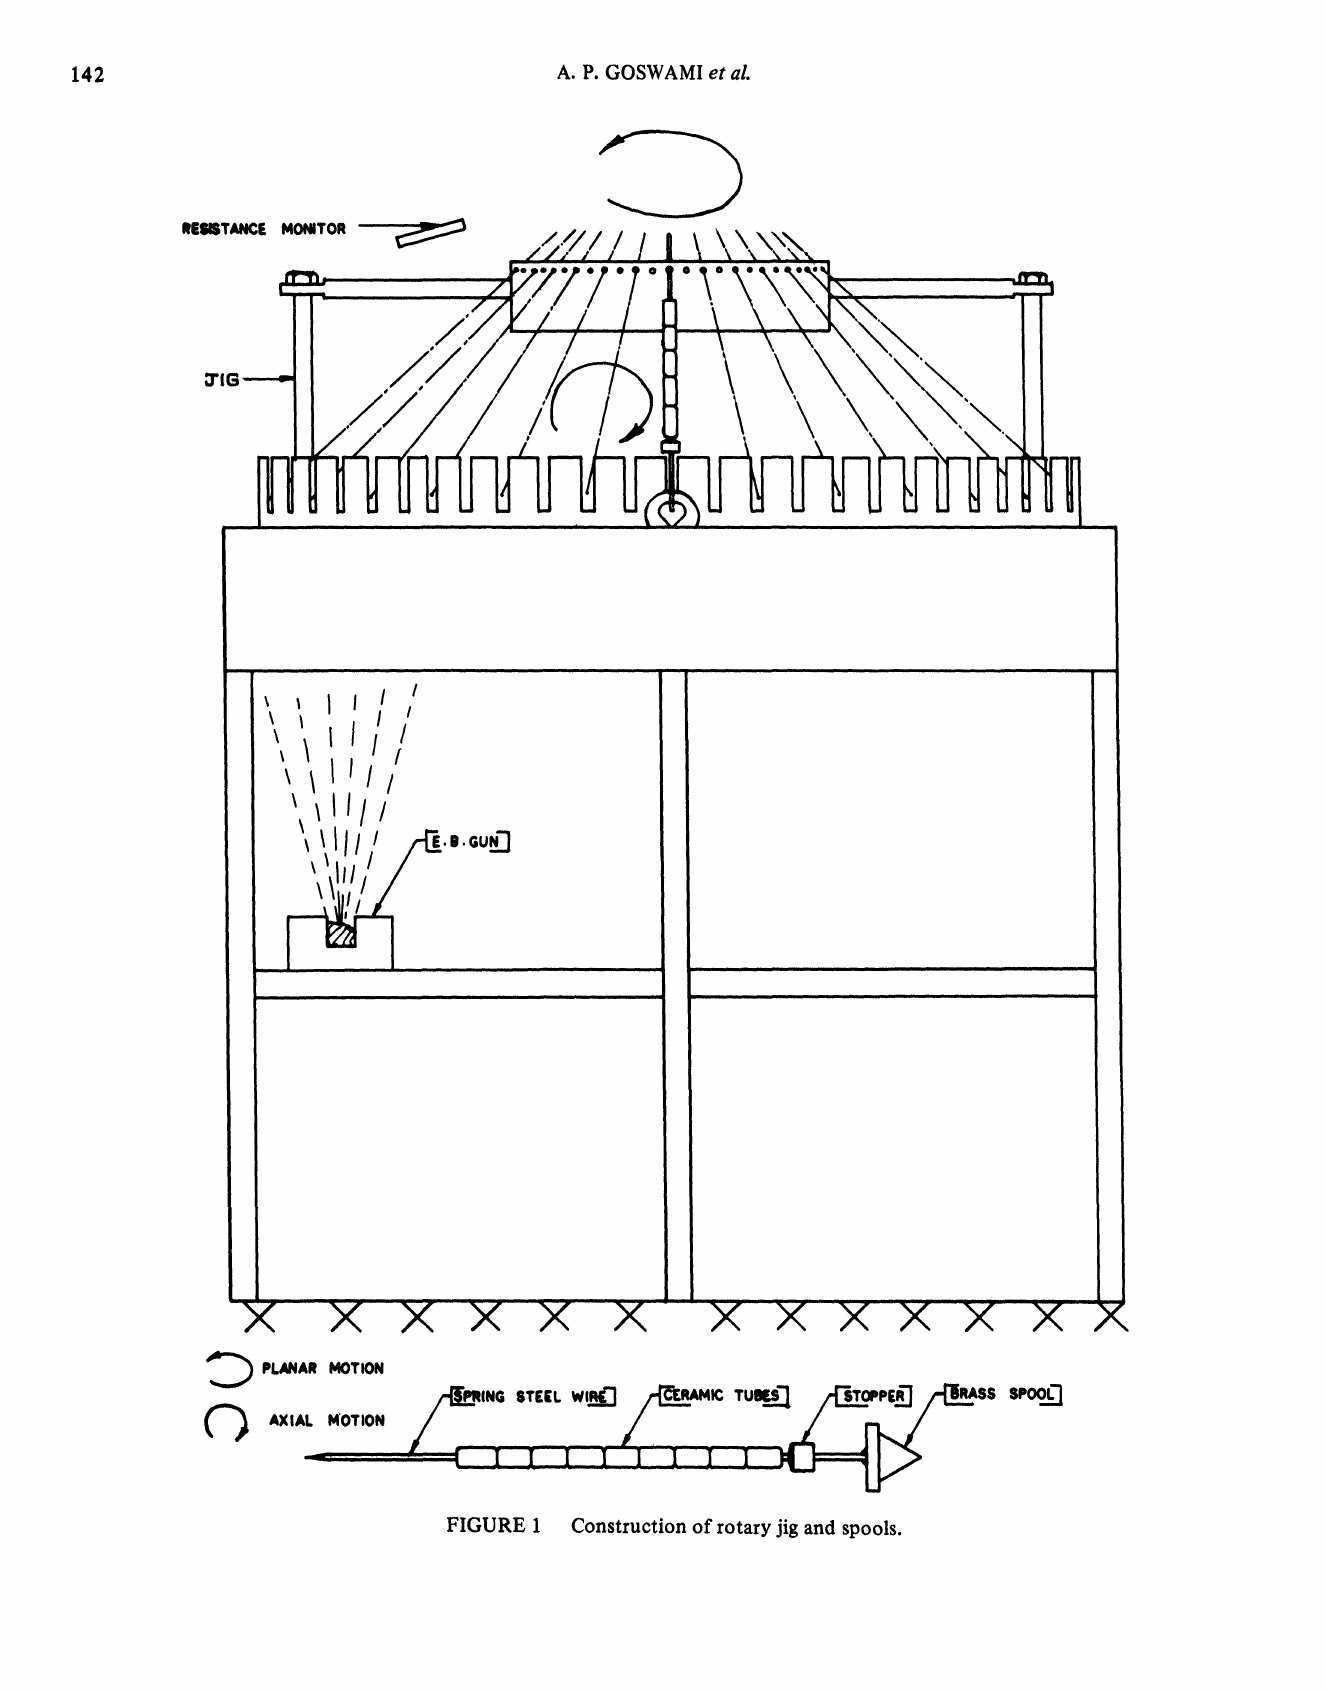
FIGURE Construction of rotary jig and